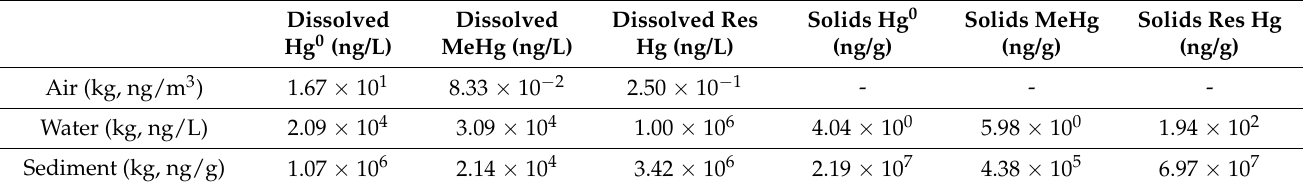
Table 3. HERMES results by Hg species: elemental (Hg0), methylmercury (MeHg), residual